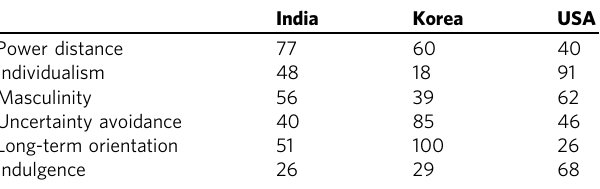
Table 1 Hofstede ’ s national culture